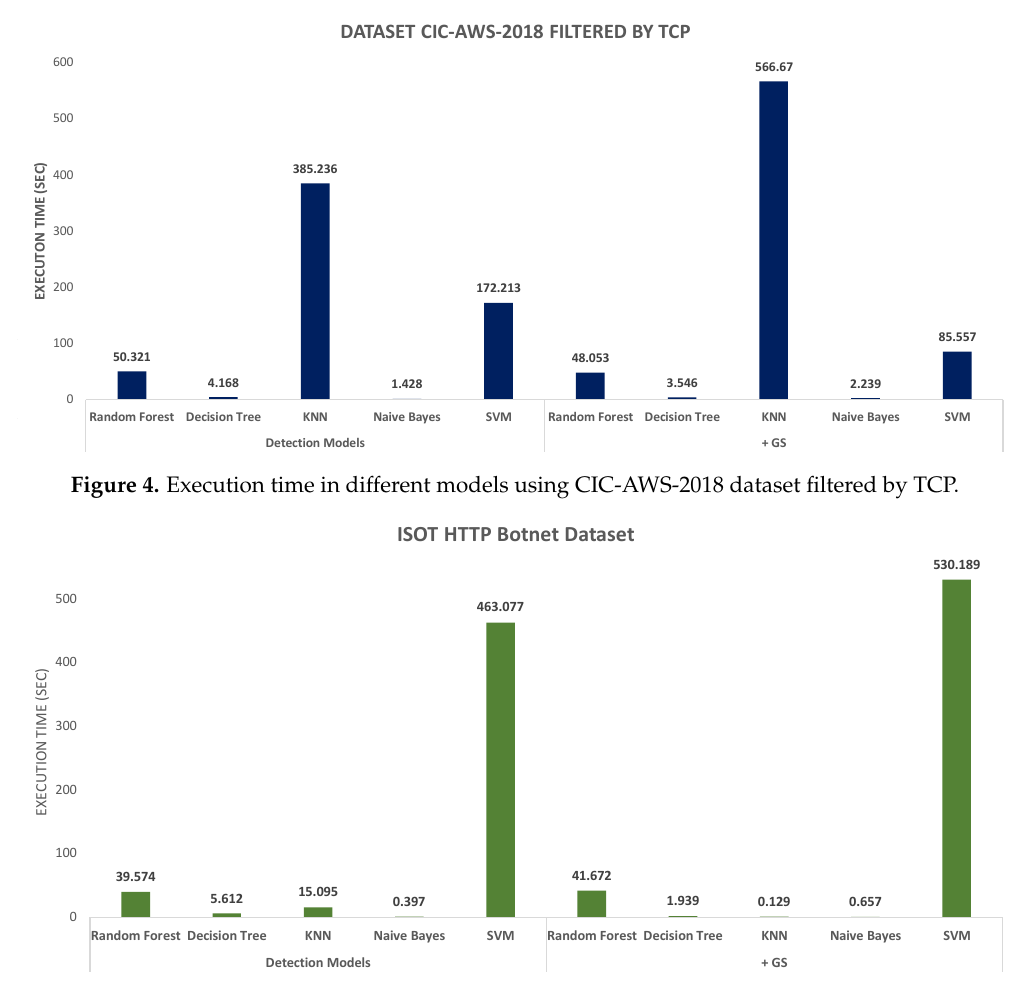
Figure 5. Execution time in different models using ISOT HTTP Botnet dataset.